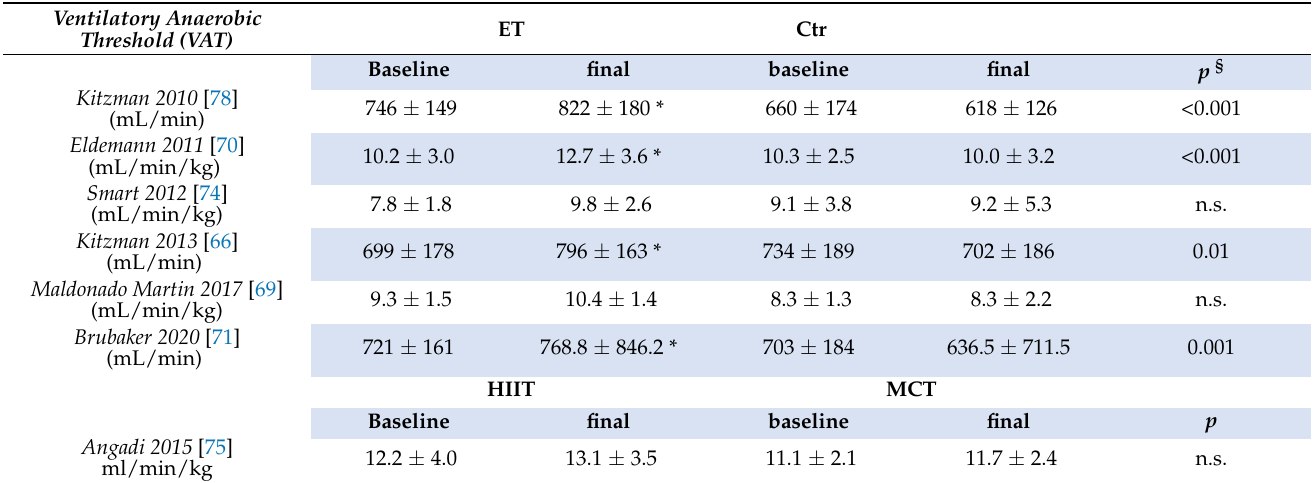
Table 3. Results of trials investigating the effects on ventilatory anaerobic threshold (VAT) of exercise training in